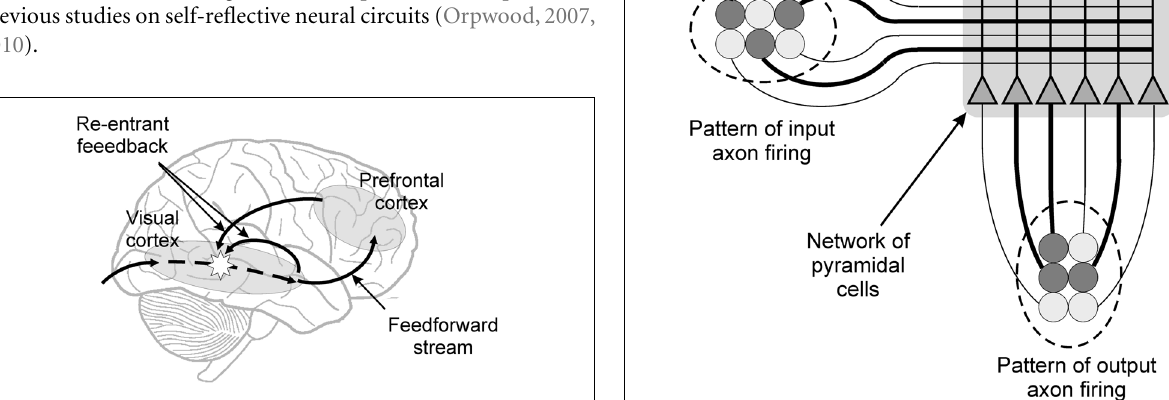
FIGURE 2 | Diagram illustrating the processing of spatial patterns of information by a network of pyramidal cells. The darker components of the input and output patterns, and the darker axonal connections, both represent firing